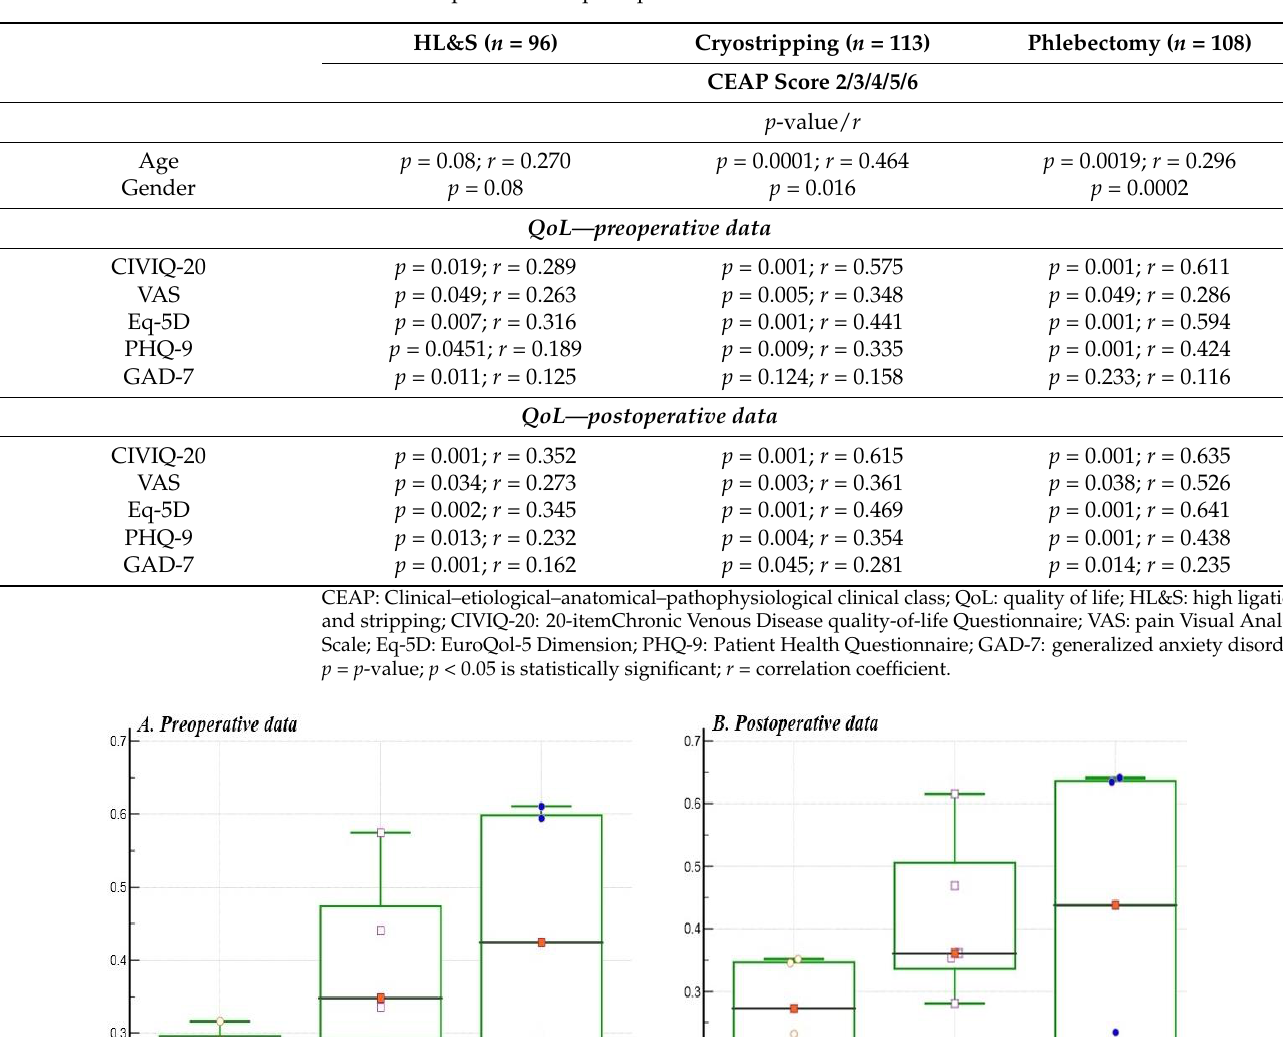
Table 2. Preoperative and postoperative data.